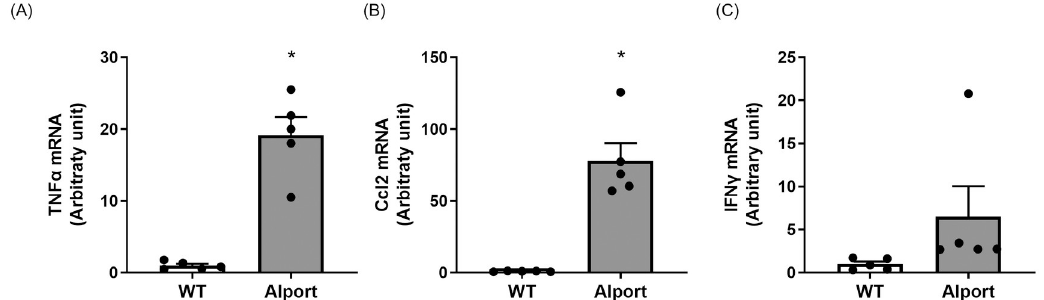
Fig 4. Elevated expression of inflammation-related factors in the kidney of Alport mice. Expression levels of TNF- α mRNA (A) and ccl2 mRNA (B) were significantly increased and IFN ɤ mRNA expression tended to increase in the diseased kidney (C). Relative mRNA expression was calculated as the ratio to GAPDH expression. The actual values are represented as dots and the columns represent mean + SE. � p < 0.05, significant difference versus WT (Student’s t-test). WT: wild type mice, Alport: Alport